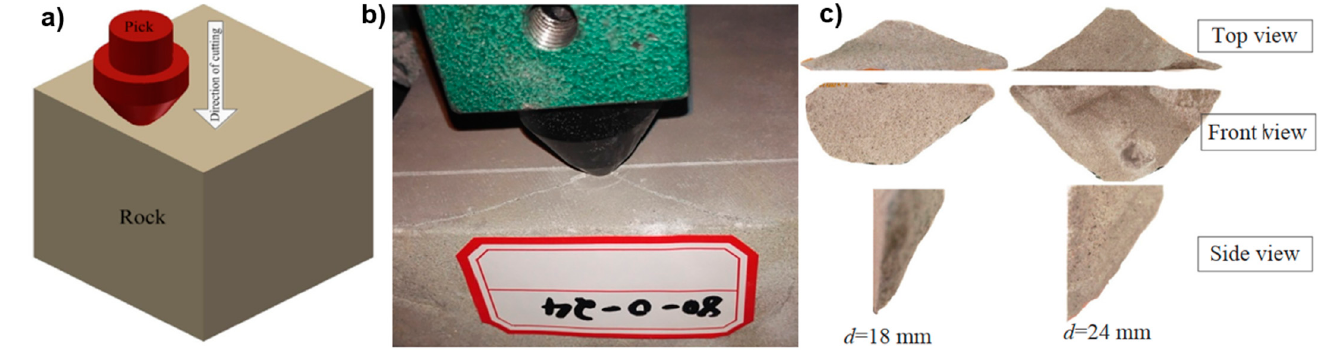
Figure 5. Laboratory tests of rock chipping with a conical pick for different distances from the sample edge [35]: ( a ). general view of pick and rock, ( b ). experimental model, ( c ). exemplary rock chips.